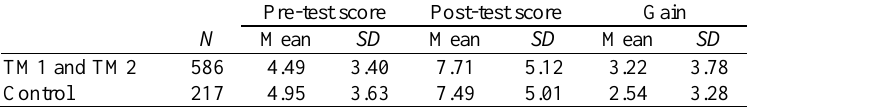
Figure 1 Mean pre- and post-test scores for the TM groups as a whole and for each of TM1 and TM2 separately Table 2 Mean pre- and post-test scores, standard deviations ( SD ) and gains for the TM groups as a whole Pre-test score Post-test score